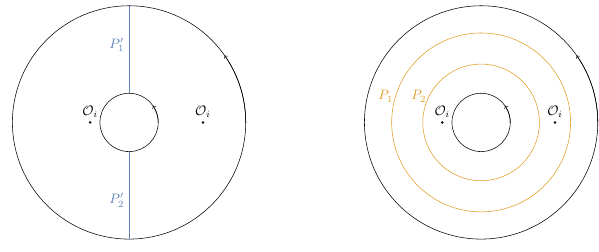
Figure 9 . Bird’s-eye view of a torus two-point function with identical external operators in two different (bulk) decompositions: the “necklace” channel (left) and the “bagel” channel (right).